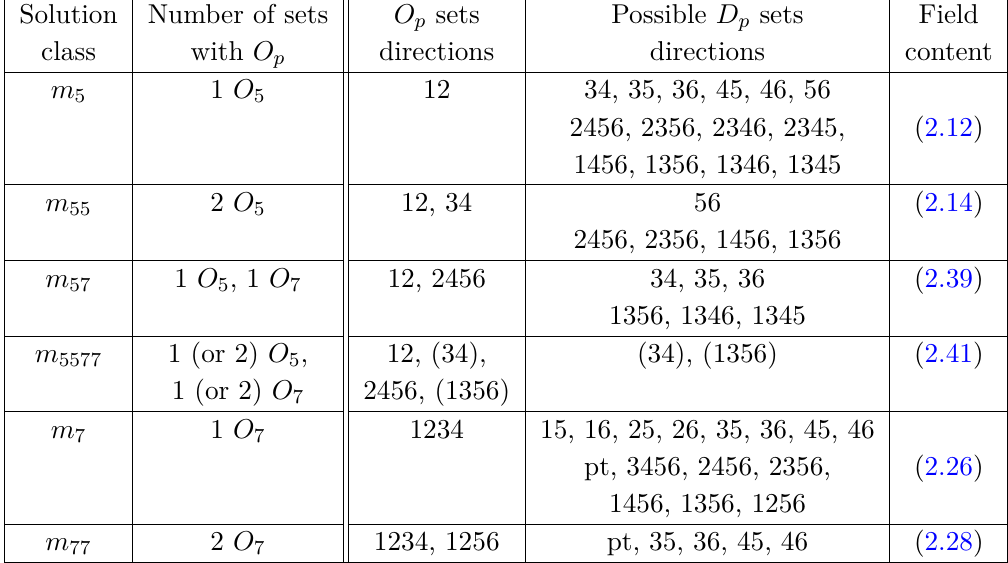
Table 4 . Source configurations in type IIB supergravity allowed by our ansatz for multiple di- mensionalities with at least one O content. These two pieces of information form together a solution class. The p = 3 sources are located at a point, denoted pt . The cases of 1 O one class: they all give the same allowed variables and the same four sources (up to their O